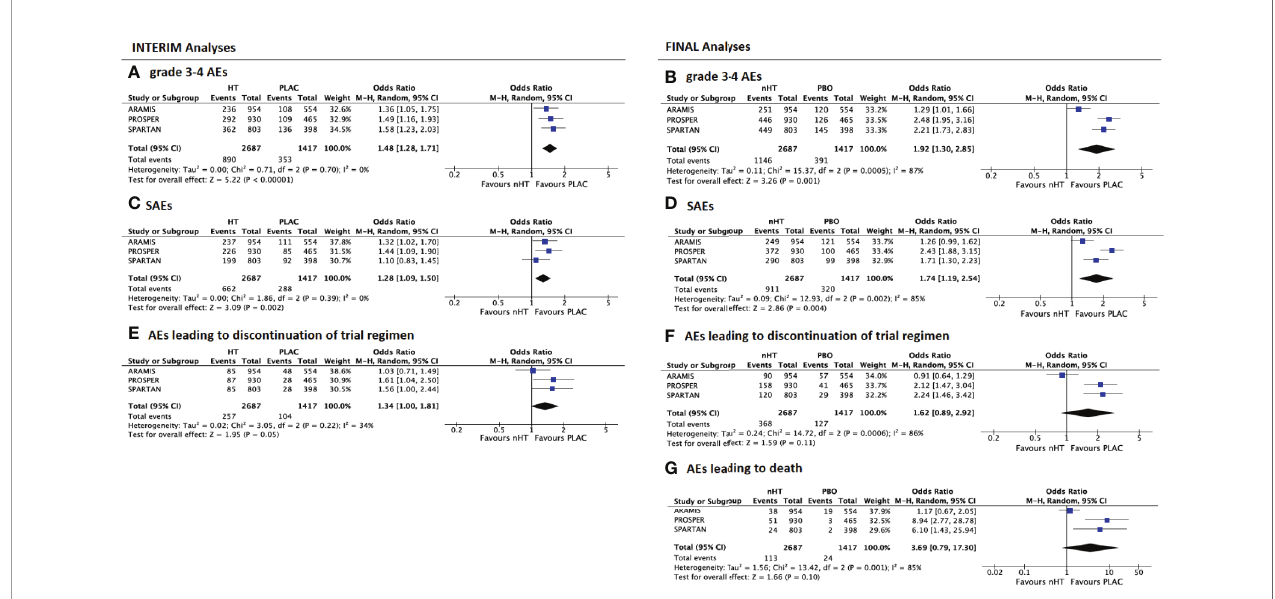
FIGURE 2 | Forest plots reporting pooled safety outcomes from both interim and fi nal analyses of the 3 included studies. Grade 3 – 4 adverse events (AEs) from interim (A) and fi nal analyses (B) ; serious AEs (SAEs) from interim (C) and fi nal analyses (D) ; AEs leading to discontinuation of trial regimen from interim (E) and fi nal analyses (F) ; AEs leading to death from fi nal analyses (G) . [CI, con fi dence interval; nHT, novel hormonal therapy; PLAC, placebo].